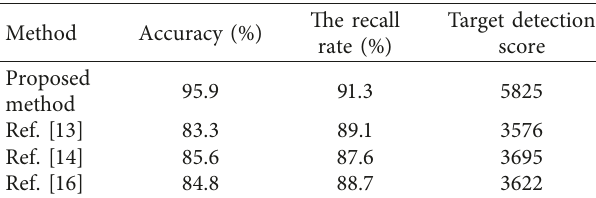
Table 2: The recall rate and accuracy of detection results of dif- ferent methods.